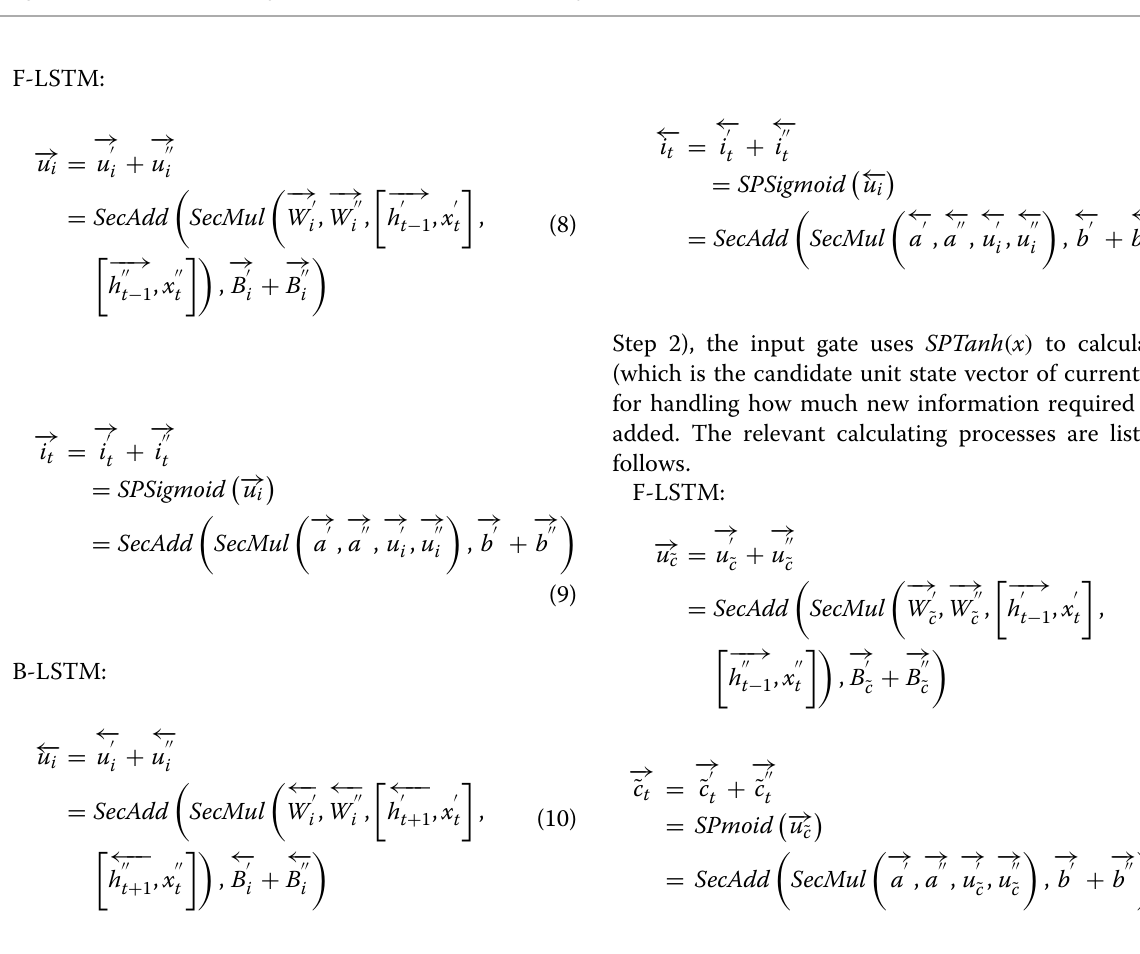
Fig. 3 The secure forward propagation and the secure backward propagation of BiLSTM on S 1 and S